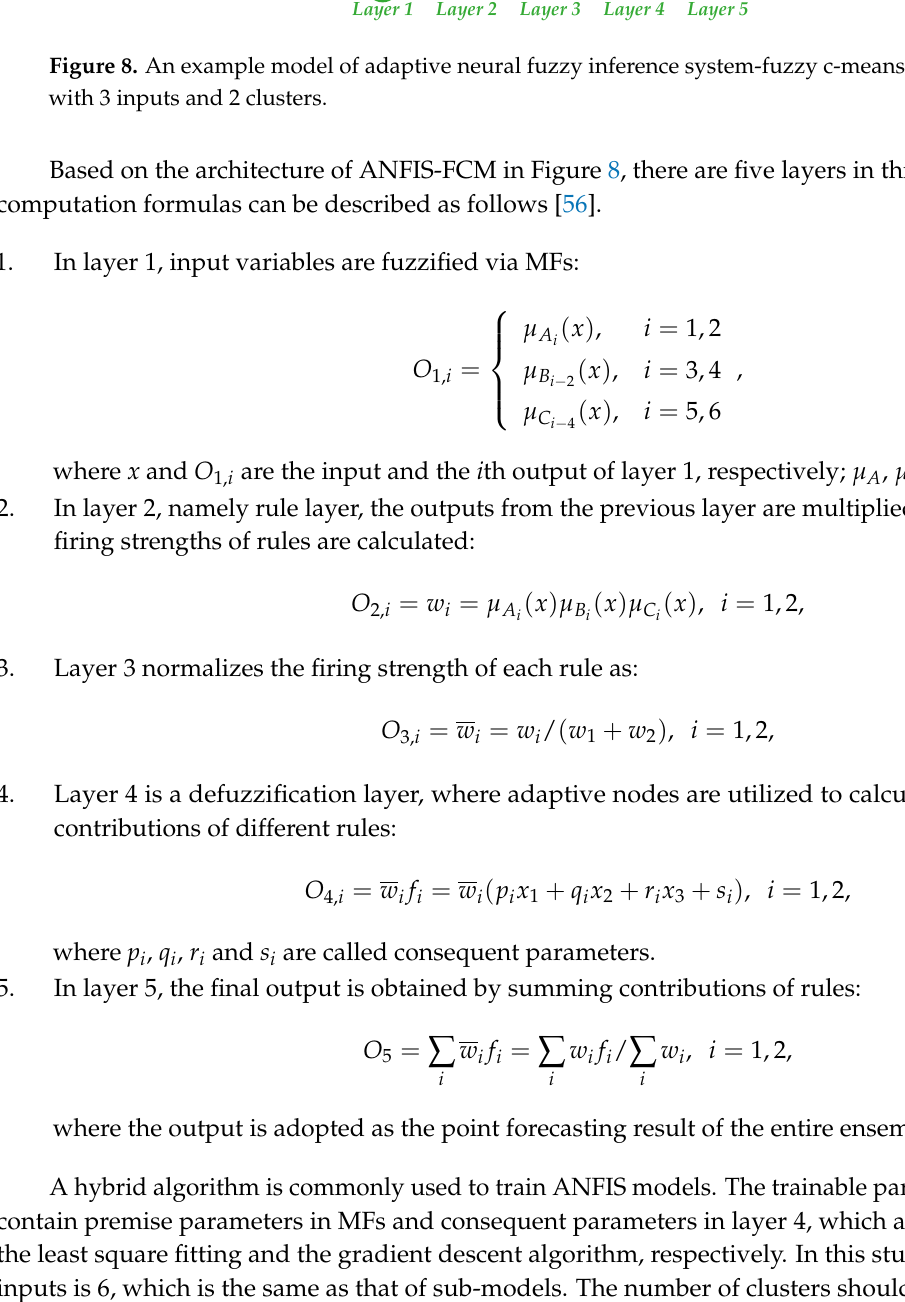
Table 3. The structure of the utilized ANFIS-FCM.